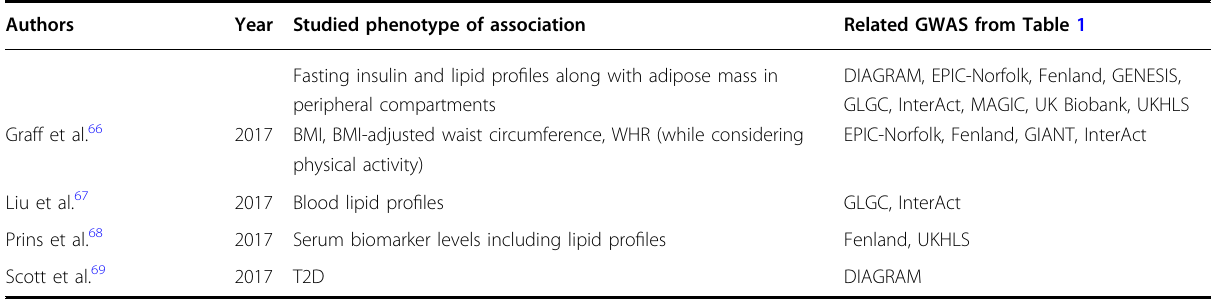
obesity and type 2 diabetes across relevant organs. The included data sets range from individual studies to large data sets curated by many international consortia.